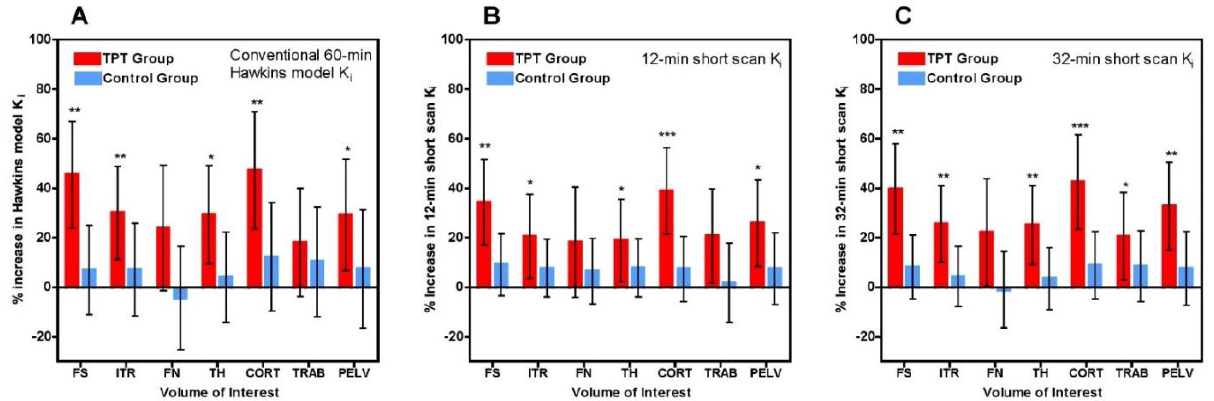
Figure 4. ( A ) Mean percentage change in 60-min Hawkins model K i values between baseline and week 12 for teriparatide (TPT) treated and control groups for each of the seven volumes of interest (VOI) (FS: femoral shaft VOI; ITR: intertrochanteric VOI; FN: femoral neck VOI; TH: total hip VOI; CORT: cortical bone VOI; TRAB: trabecular bone VOI; PELV: pelvis VOI). Error bars are 95% CI. ( B ) Same as ( A ) but for the 12-min short-scan K i data. ( C ) Same as ( B ) but for the 32-min short-scan K i data. * p < 0.05 relative to baseline; ** p < 0.01; *** p < 0.001.